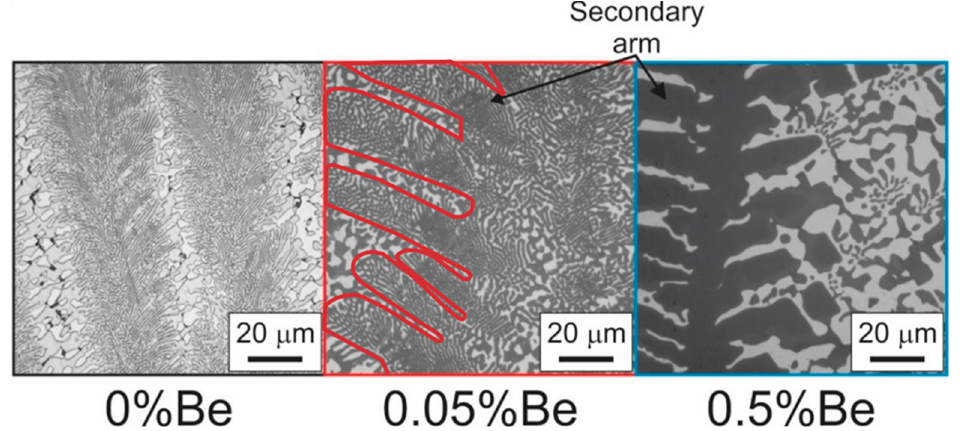
Figure 6. Longitudinal images obtained by optical microscopy for Al-33 wt.%Cu, Al-33 wt.%Cu- 0.05 wt.%Be and Al-33 wt.%Cu-0.5 wt.%Be alloys solidified under a cooling rate of 1.6 °C/s. The red line contour delimitates secondary arms of a dendritic morphology.